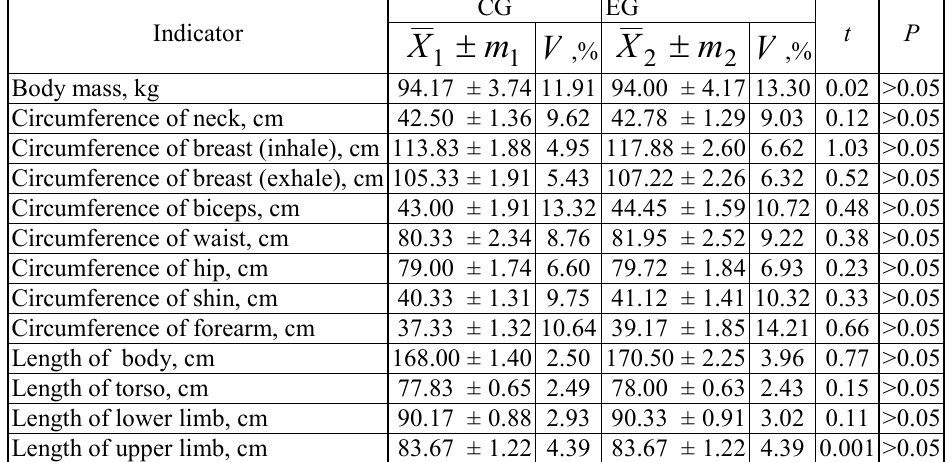
Mean anthropological indicators of qualified bodybuilders of control and experimental groups at